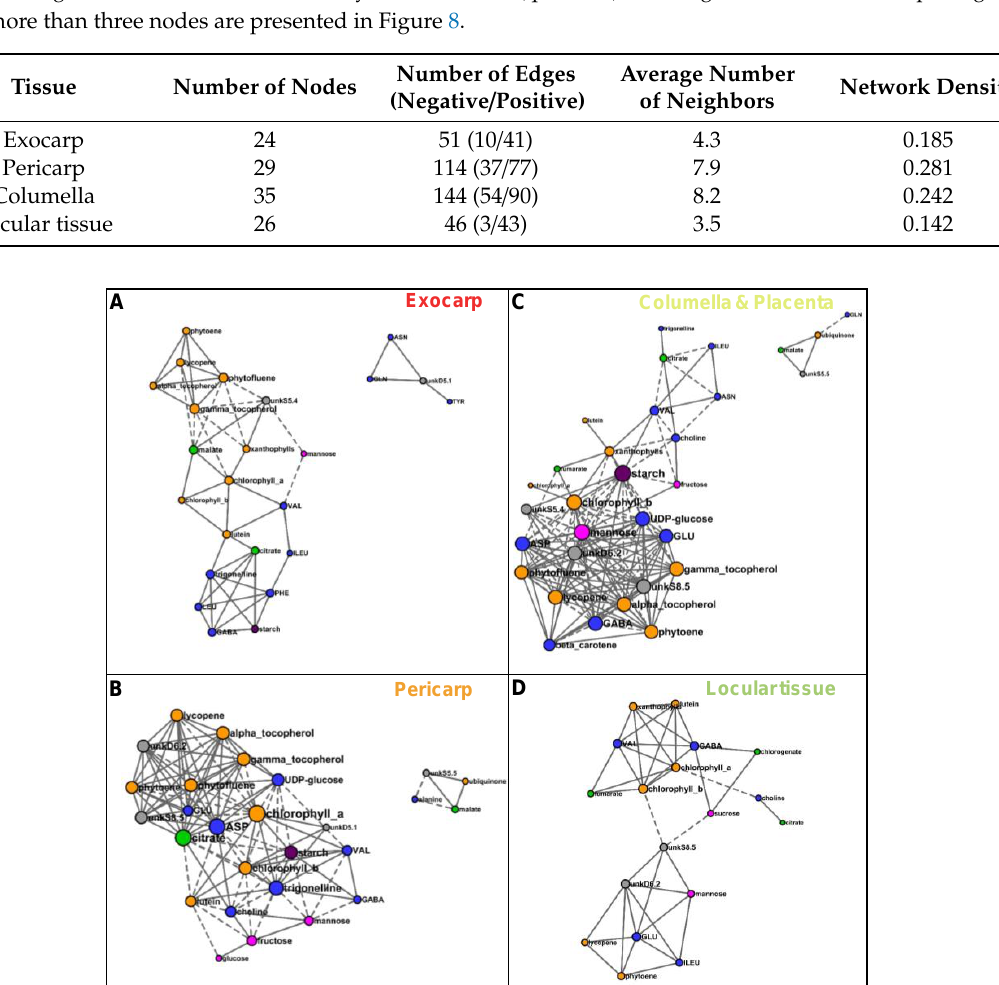
Table 1. Parameters of the correlation networks for four tomato fruit tissues based on the absolute contents of 39 metabolites and starch along fruit development measured by 1 H-NMR, LC-DAD, or enzymatic analyses and expressed on a DW basis. For each tissue, correlations were filtered based on their significance with a false discovery rate correction (q < 0.001). The larger sub-networks comprising more than three nodes are presented in Figure 8. Tissue Number of Nodes